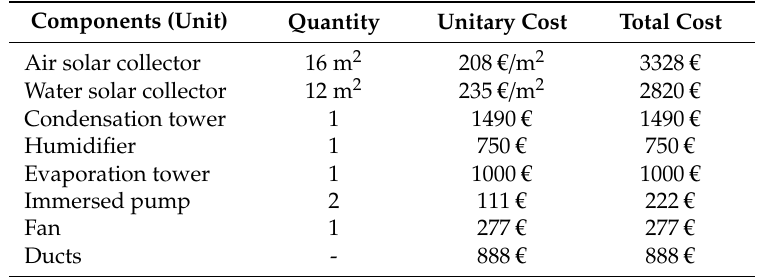
Table 1. Investment cost of each component involved in the desalination